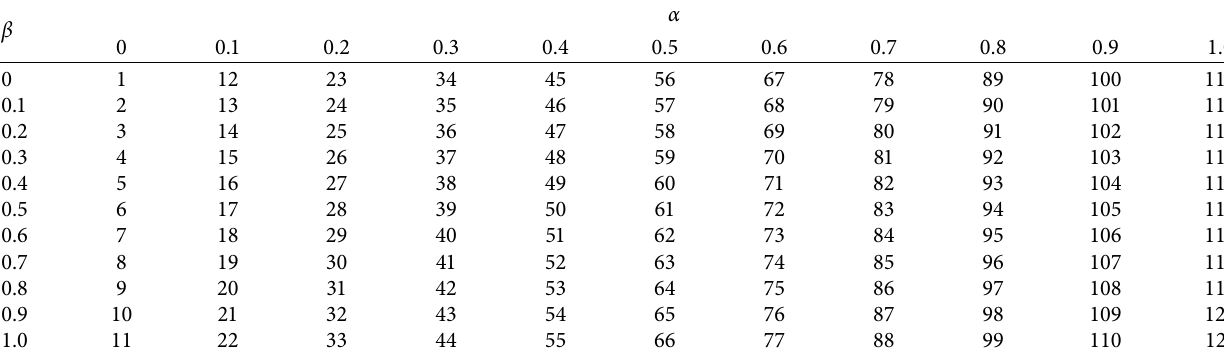
Figure 3: The optimal location distribution of comprehensive score values under different index weights. Table 12: Position numbers corresponding to different market penetration.